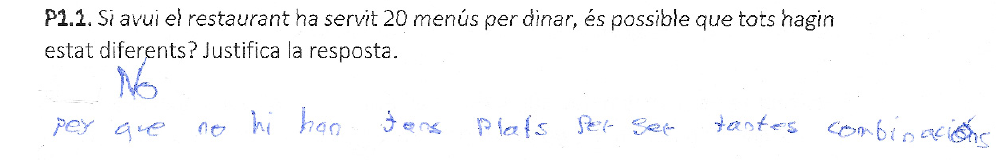
Figure 1. Partially correct answer of Q1 (translation: no because there are not so many dishes to make so many combinations. The student answers 18 in Q2 ).